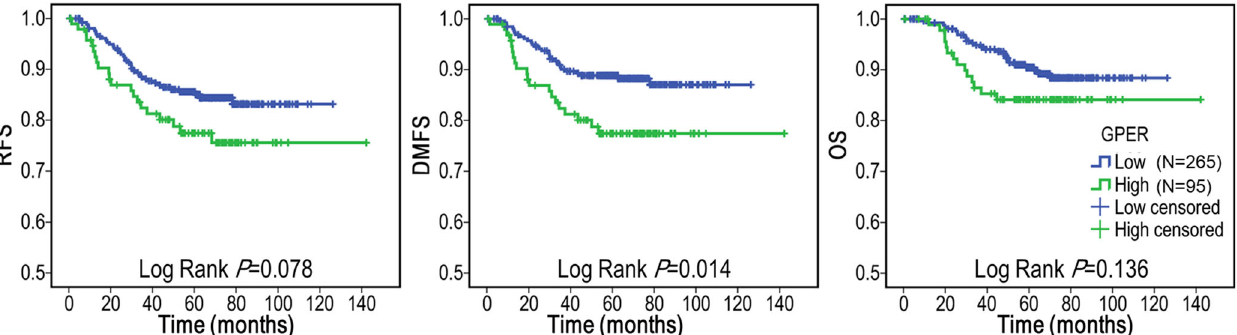
Fig. 3 Kaplan – Meier survival curves of RFS, DMFS, and OS between GPER-low and GPER-high groups in patients with TNBC. Statistically signi fi cant differences were de fi ned as P < 0.05. Abbreviations: RFS relapse-free survival; DMFS distant metastasis-free survival; OS overall